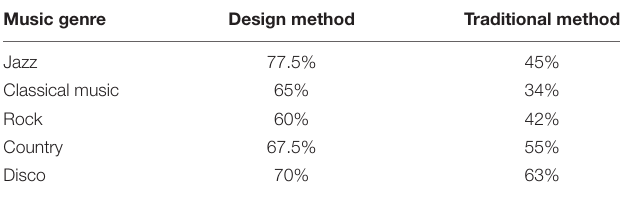
TABLE 1 | Experimental comparative analysis.